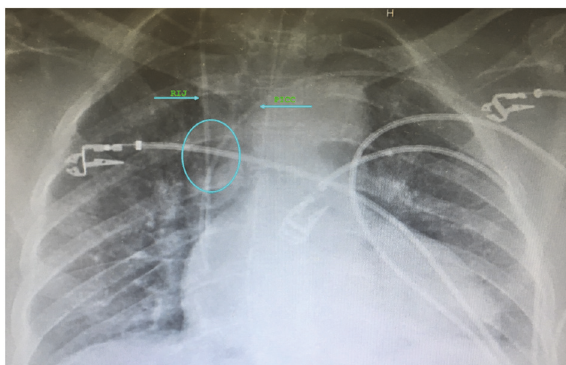
Figure 1: Chest X-ray showing multiple superficial EKG electrodes, left upper extremity PICC line with RIJ central venous catheter optimally positioned at right atrium and SVC junction, importantly with 45-degree angle at convergence.